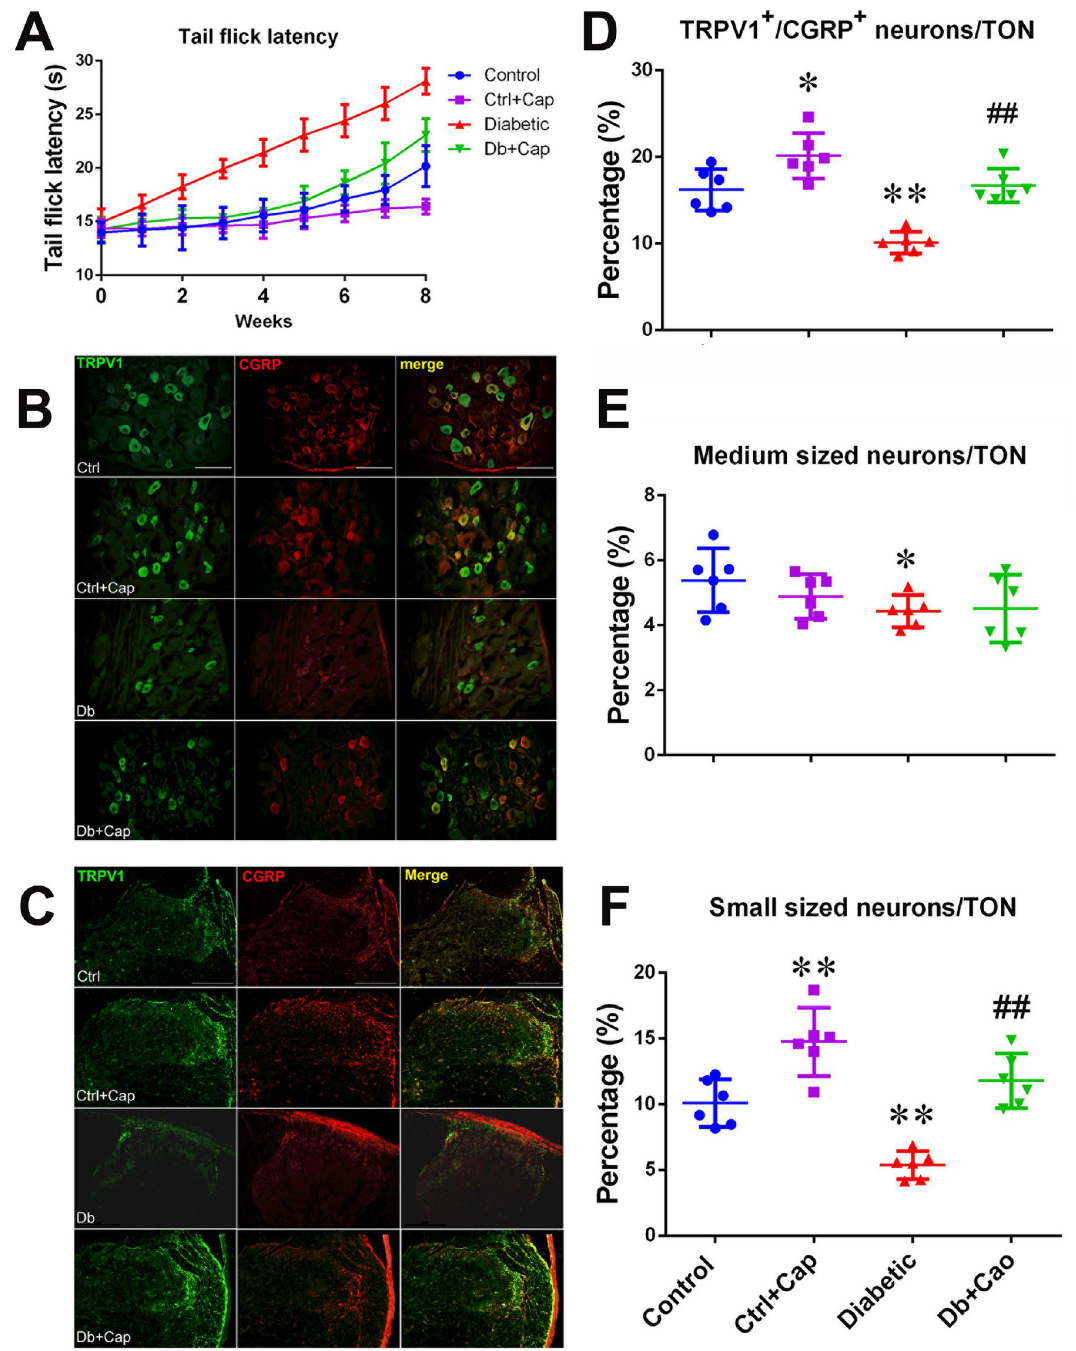
Figure 2. Preservation and impairment of the peripheral sensory nerves. Significant attenuation of the elevation of tail flick latency ( A ) was observed paralleling the preservation of CGRP-expressing DRGs ( B ) and in the spinal dorsal horn ( C ), at the 5th lumber segment of the animals from the capsaicin treated diabetic group, stained with antibodies for TRPV1 (in green) and CGRP (in red) and the mergers (in yellow), showing massive losses of the expressions of TRPV1 and CGRP in the spinal dorsal horn, especially in the superficial laminae (marked by the circle) at the end of the 8 weeks after induction of diabetes. The preservation of the DRG neurons co-expressing TRPV1 and CGRP ( D ), the medium diameter neurons ( E ) and the small diameter neurons ( F ). Control or Ctrl non-diabetic control group, Ctrl + Cap non-diabetic animals treated with capsaicin, Diabetic or Db diabetic group, Db + Cap diabetic animals treated with capsaicin, TON total observed neurons. * p < 0.05, compared to the control; ** p < 0.01, compared to the control; ## p < 0.01, compared to the diabetic. The scales = 100